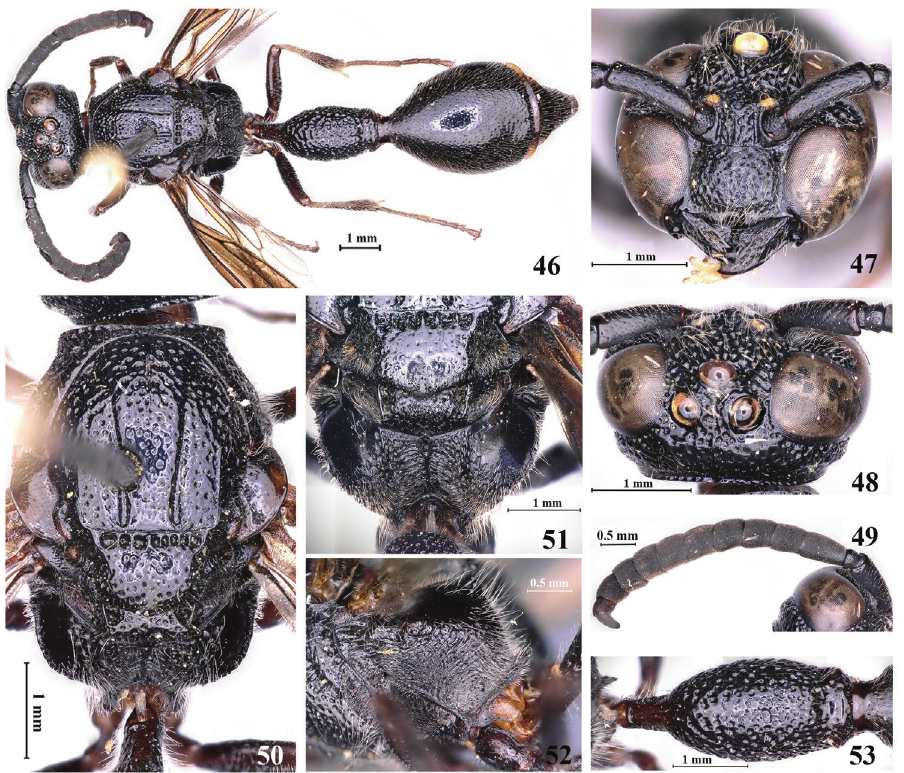
Key to species of the genus Zethus from the Oriental region 1 T1 about 5× as long as wide in dorsal view ......... Z. fulgens Gusenleitner, 2007 – T1 at most 4.2× as long as wide in dorsal view (Figs 10, 23, 34, 43, 53) ........... 2 2 Head and mesosoma with dense and long golden orange setae .......................... 3 – 3 Apical lamella of T3 indistinct; mesoscutum with large and dense punctures ...... – Apical lamella of T3 distinct; mesoscutum with indistinct punctures ................ 4 4 S2 with developed lamella; in female, apical margin of S3 with a punctate median lobe; in male, antennae black, apical flagellomere rounded apically; apical margin of clypeus without teeth ..................................................... Z. soikai Selis, 2017 – S2 without apical lamella; in female, apical margin of S3 without lobe; in male, antennae orange, apical flagellomere pointed apically; apical margin of clypeus with two triangular teeth ............................ Z. luzonensis Giordani Soika,